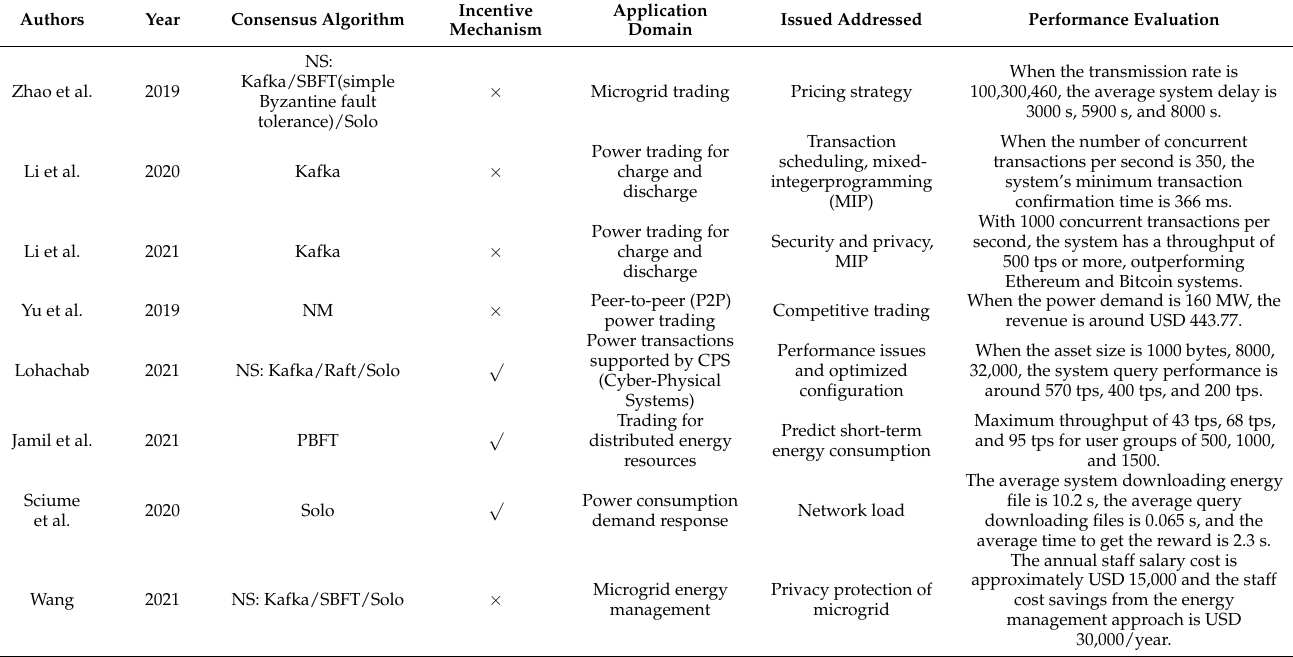
Table 5. Differences between schemes of smart grid (NS: mention but not specify, NM: not